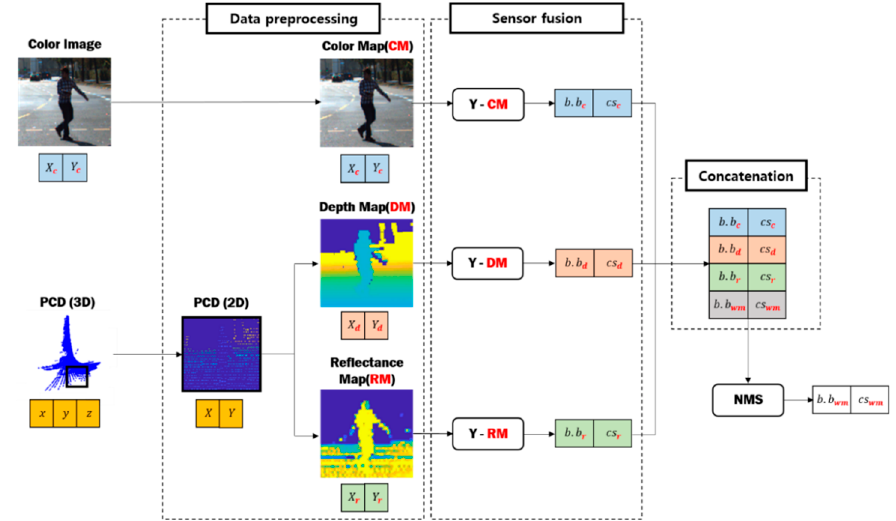
Figure 3. Schematic of the proposed multimodal mixture-of-YOLOs framework.